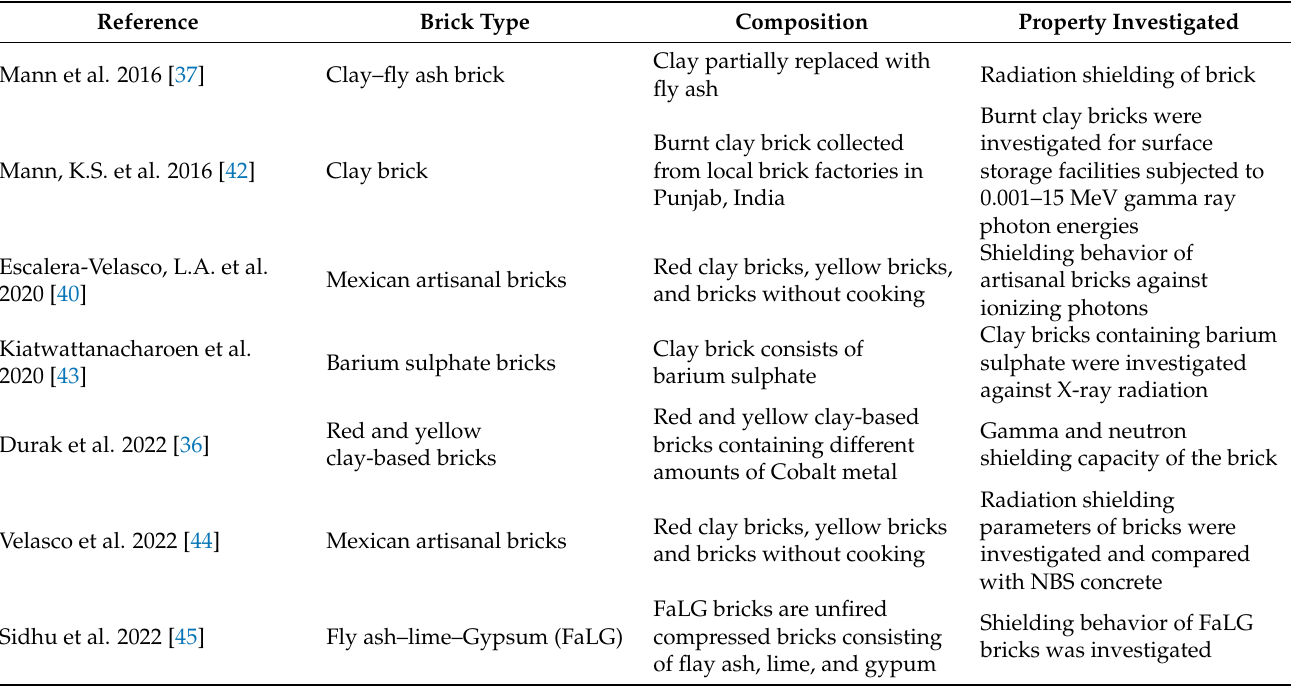
Table 1. Summary of the previous literature concerning the use of bricks against radiation